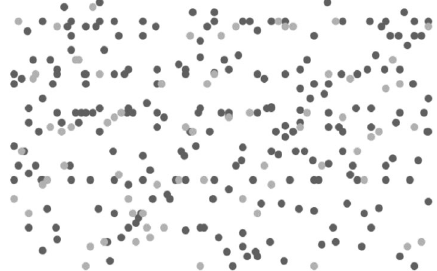
Figure 7. Before running the DPT algorithm.